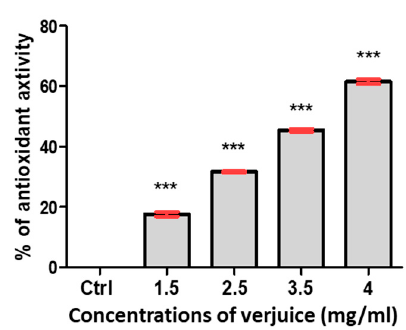
Figure 1. Antioxidant activities of different concentrations of verjuice extract. The samples were prepared in triplicates. The results are expressed as the percentage of control (0 mg/mL verjuice). Each value represents the mean ± standard deviation (SD) of triplicates. *** p < 0.001.